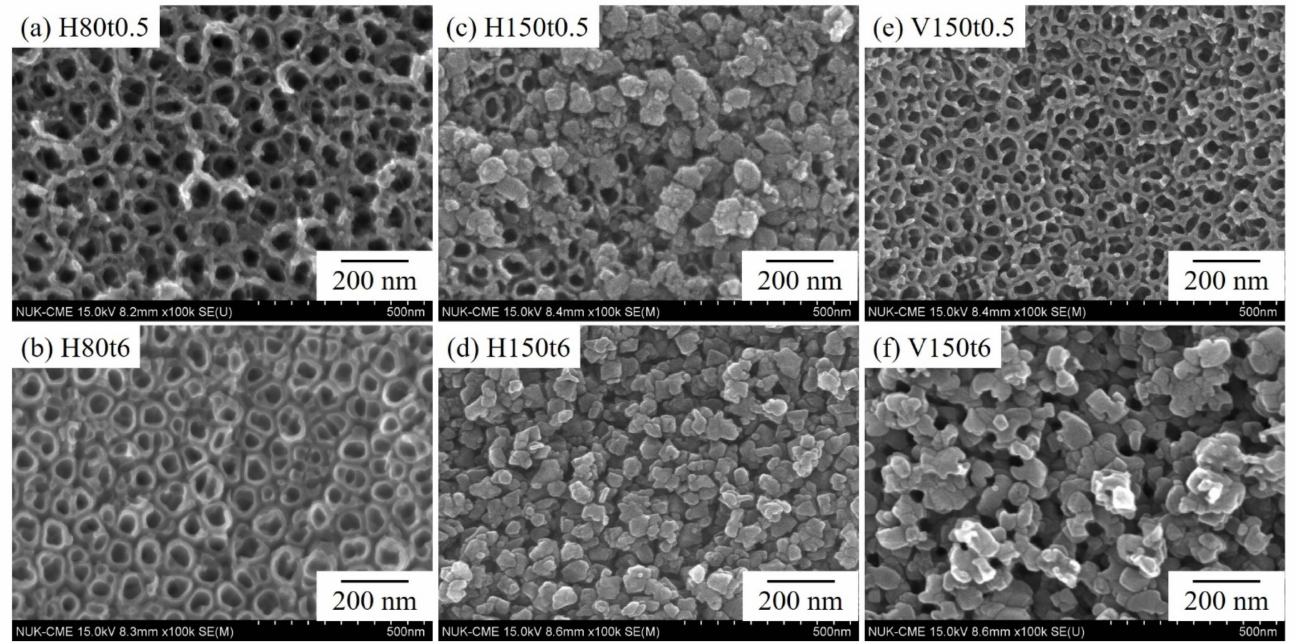
Figure 2. SEM images of anodized Ti–5Nb–5Mo under various hydrothermal or vapor thermal treatments: ( a ) H80t0.5, ( b ) H80t6, ( c ) H150t0.5, ( d ) H150t6, ( e ) V150t0.5, and ( f )